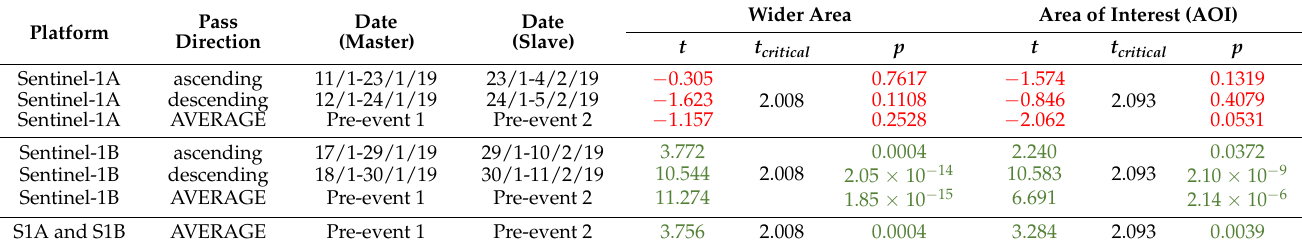
Table 4. t-test results for coherence values from Sentinel-1A, Sentinel-1B in ascending and descending pass direction, and average Sentinel-1A and Sentinel-1B coherence values. The successful tests are in green, whereas those that failed are in red.